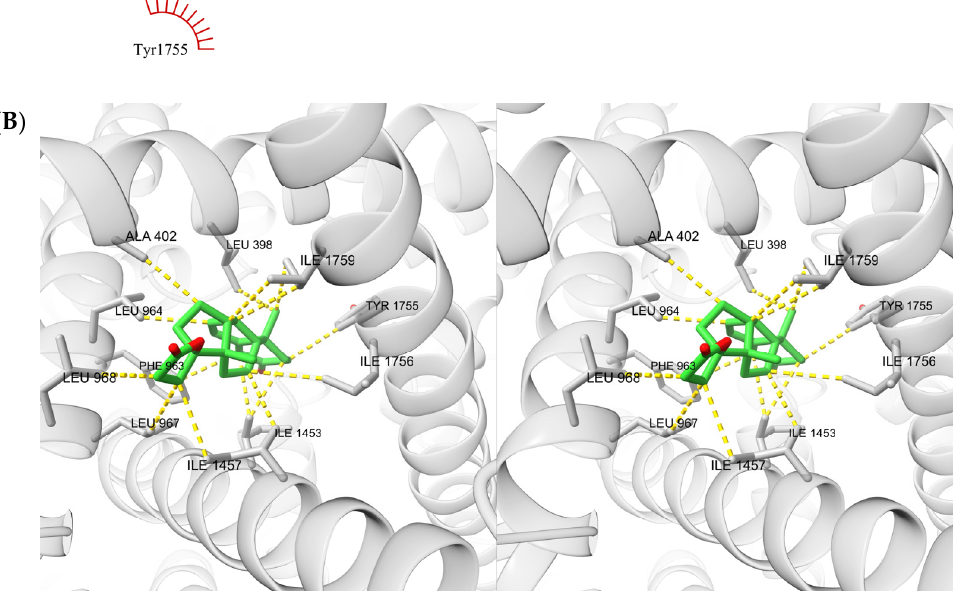
Figure 4. Interactions of first-ranked ligand. ( A ) Interactions as shown in LigPlot+. ( B ) Interactions as detected by PLIP shown in ChimeraX 3D cartoon and stick representation (cross-eye stereoimage).